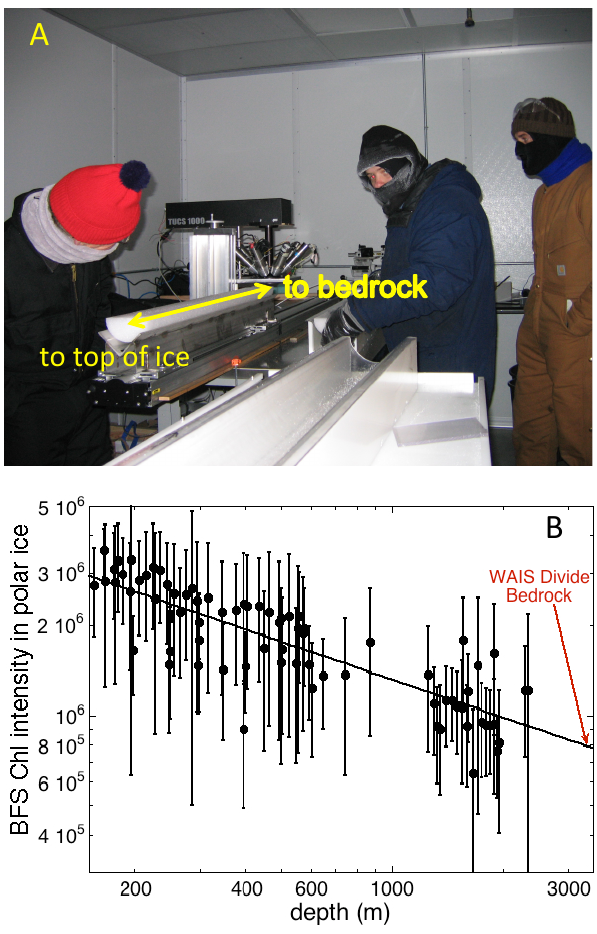
Fig. 2. (A) The Berkeley Fluorescence Spectrometer (BFS) maps fluorescence of Trp and Chl with 1400spectram − 1 in 2min. Ice protects phototrophic cells from photobleaching. (B) Intensity of Chl autofluorescence in ice cores from 7 polar ice locations: 2 sites in Greenland (GISP2 and site D4), 3 sites in West Antarctica (WAIS Divide, Ross Ice Drainage System (RIDS) and Siple Dome), and 2 sites in East Antarctica (Vostok and South Pole). Depths extend from 120m to 2300m; each point is an average over ∼ 10 3 depths per metre and over the 7